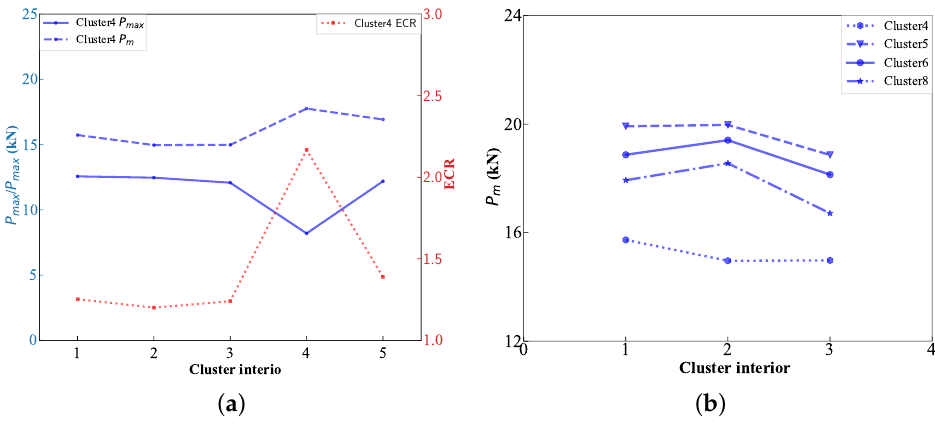
Figure 13. ( a ) P max , P m and ECR for the internal model of Cluster 4; ( b ) P m of origami tubes near the center of mass for different clusters.